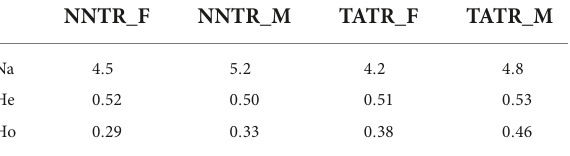
genetically differentiated populations ( Supplementary Figure 1 and Supplementary Table 2 ). A minimal amount of gene flow was found between the two populations (